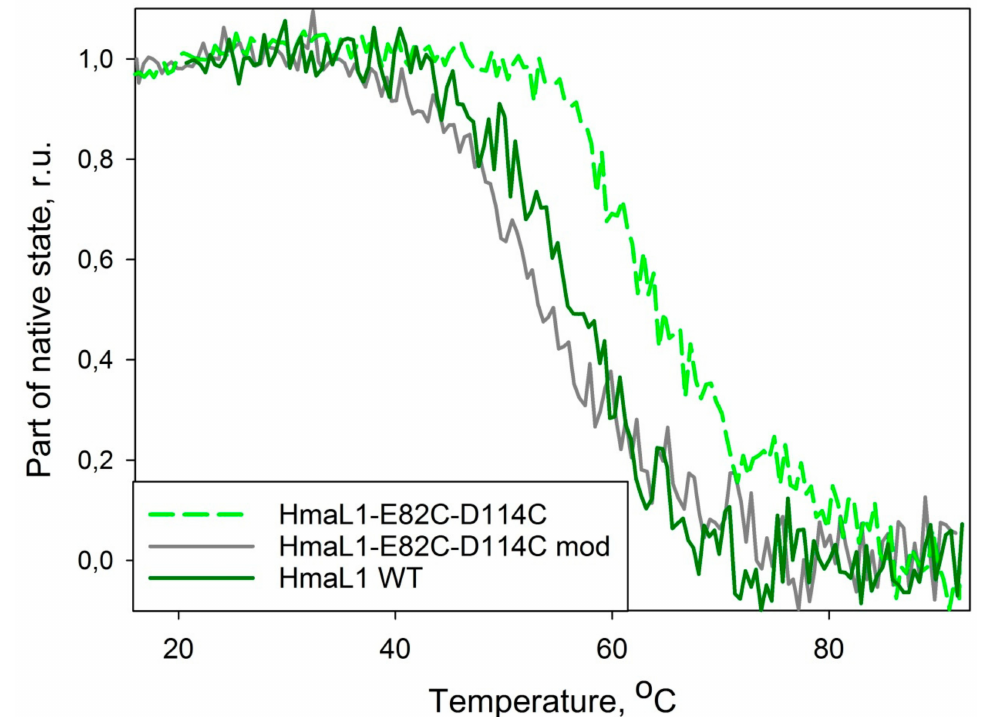
Figure 7. Dependency of fraction of native state of wild type HmaL1 (HmaL1 WT, solid green line), mutant with inserted disulfide bridge (HmaL1–E82C–D114C, dashed light-green line) and mutant form with iodoacetamide-modified sulfide group (HmaL1–E82C–D114C mod, solid gray line) on temperature. Fraction of native protein state was calculated from molar ellipticity at 215 nm